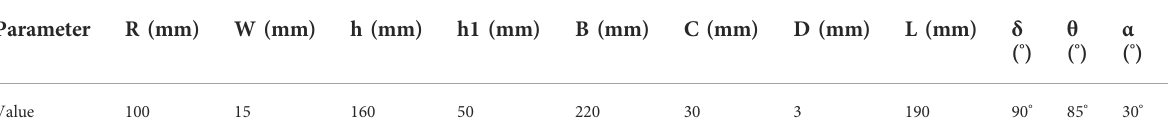
TABLE 1 Major parameters of the subsoiler.